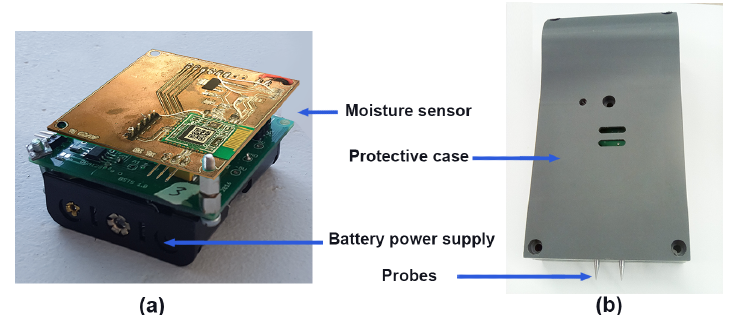
Figure 5. The BLE sensor node prototype; ( a ) the BLE sensor circuit with battery power supply, ( b ) the protective case of the BLE sensor with the measurements probe.